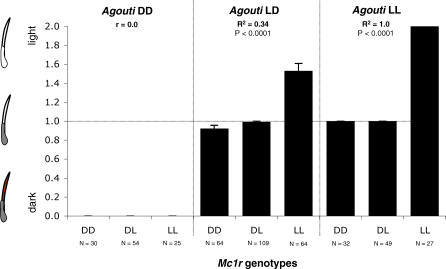
Interaction between Agouti and Mc1r Genes for One Trait, Cheek PigmentationBlack bars represent the mean phenotypic score for each Mc1r genotype when F2 progeny were clustered by Agouti genotype; alleles are indicated by dark (D) and light (L). Phenotypic values were taken for each of 465 F2 progeny, scored as 2 (no visible pigment), 1 (partially pigmented), and 0 (fully pigmented) as indicated by the cartoons of individual hairs. Sample size and standard error bars are provided. R
2 and p-values obtained by χ2 test are shown for each Agouti genotype, indicating the amount of phenotypic variation explained by Mc1r genotype in the F2 progeny.